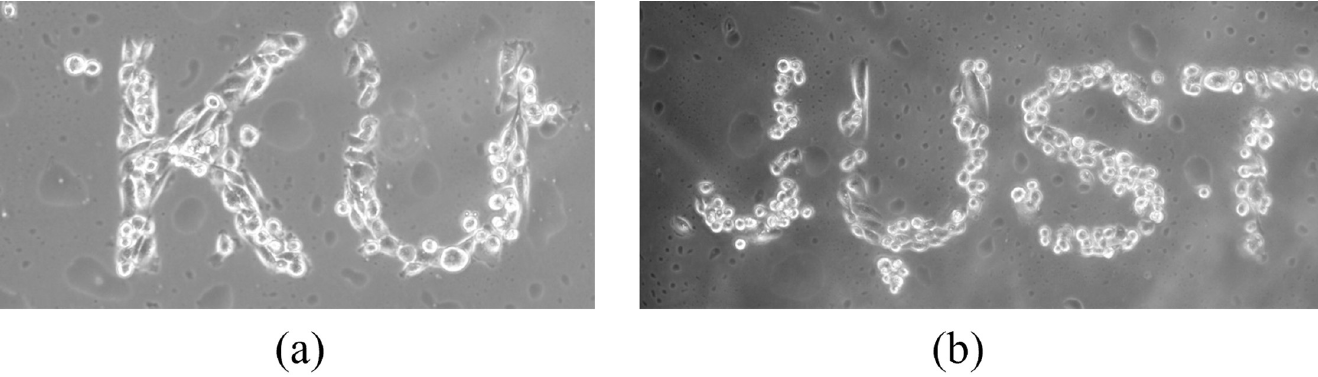
PLOS ONE | https://doi.org/10.1371/journal.pone.0269914 June 16,